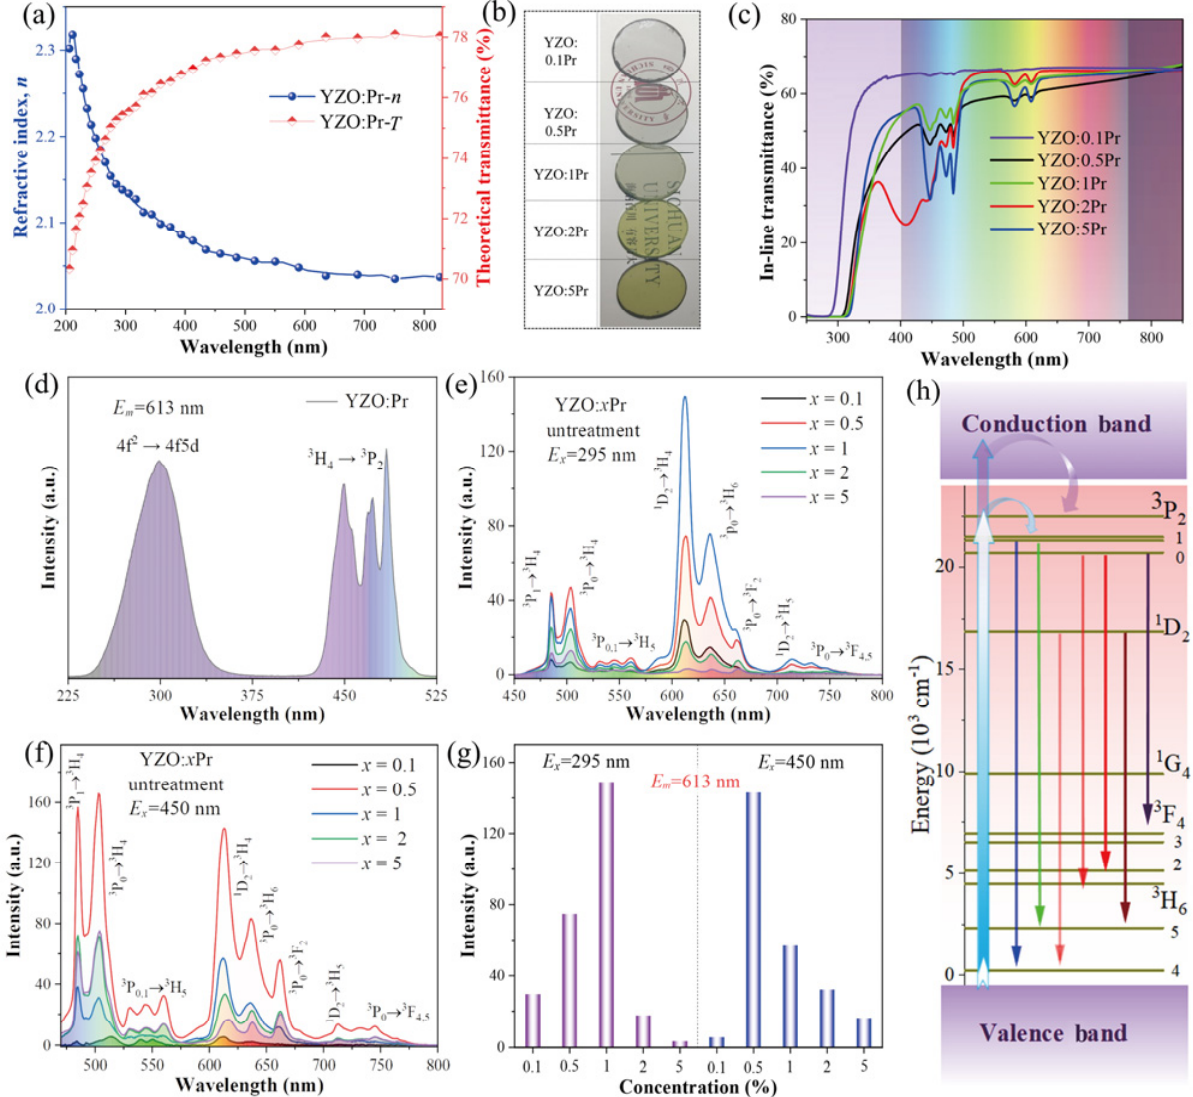
Fig. 3 (a) n and T of typical YZO:1Pr ceramic. (b, c) Photographic images and in-line transmittance of freshly sintered YZO: x Pr ( x = 0.1, 0.5, 1, 2, and 5 mol%) ceramics, respectively. (d–f) Excitation and emission spectra under the excitation of 295 and 450 nm and (g) comparison of corresponding emission intensities of YZO:Pr ceramics. (h) Schematic of the pathways of Pr 3+ PL processes. Note: E x and E m represent the excitation and emission wavelength,